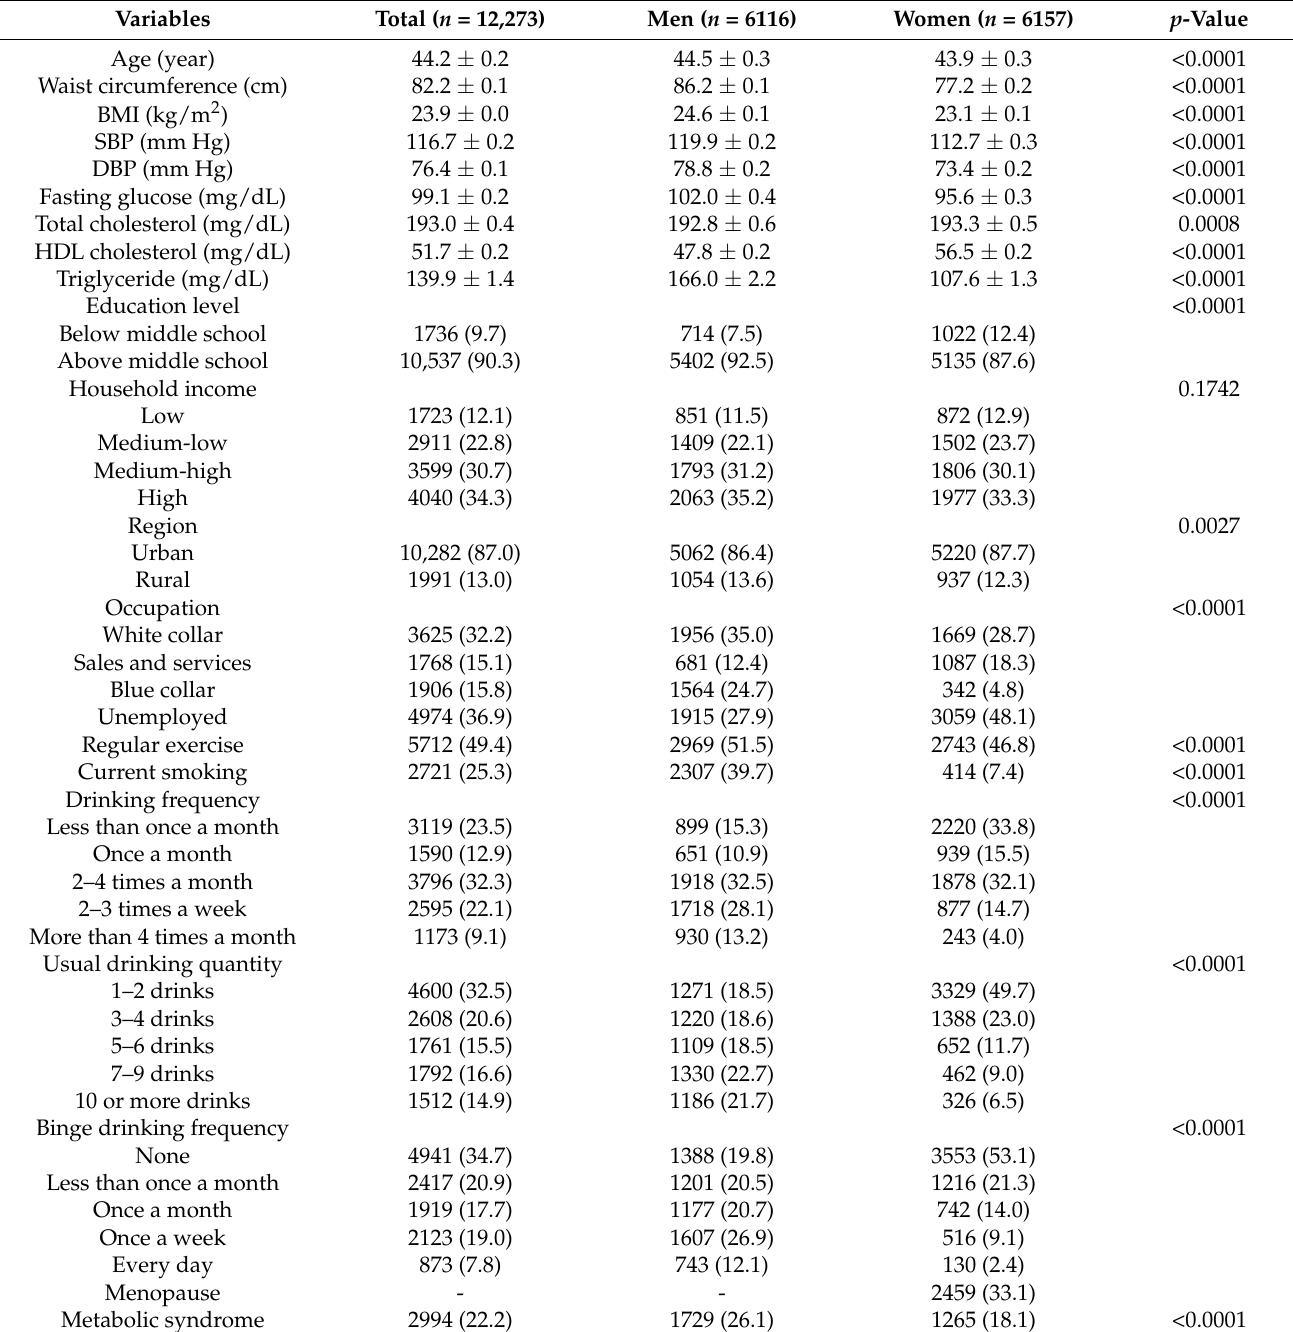
Table 1. General characteristics of the study population.